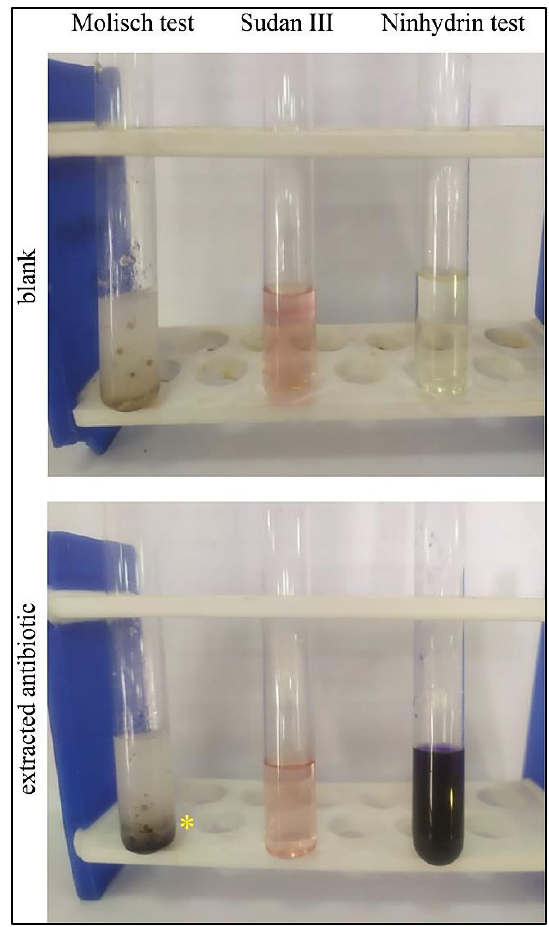
Figure 5. Chemical characterization of the antibiotic. The extracted antibiotic was tested for the presence of sugar residues using the Molisch test, for fatty acid or lipid residues using Sudan III, and for peptide residues using the ninhydrin reagent. A blank was tested for the same series of reagents as a negative control. The extracted antibiotic was positive in the Molisch test (violet ring indicated by *) and interacted positively with the ninhydrin reagent (development of purple color), whereas the antibiotic behaved the same as the blank when mixed with Sudan III.